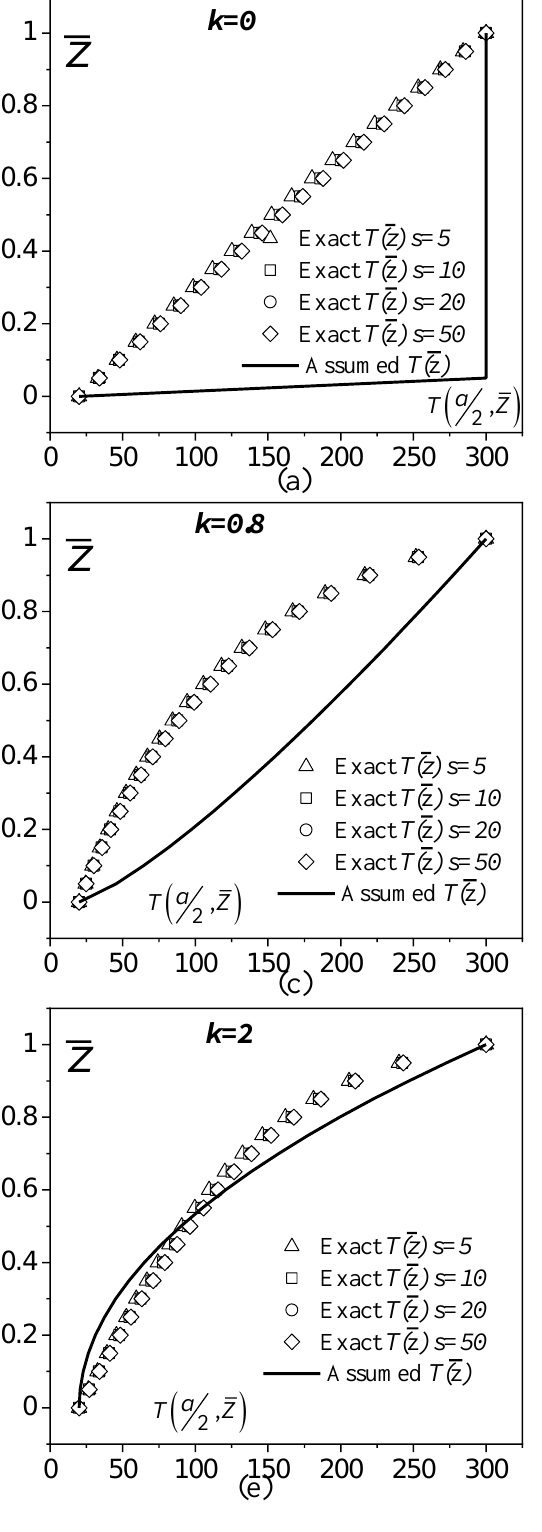
Fig. 4. Comparison between through thickness exact temperature variation and power law variation for various power index ( k) of FG laminate [Material set